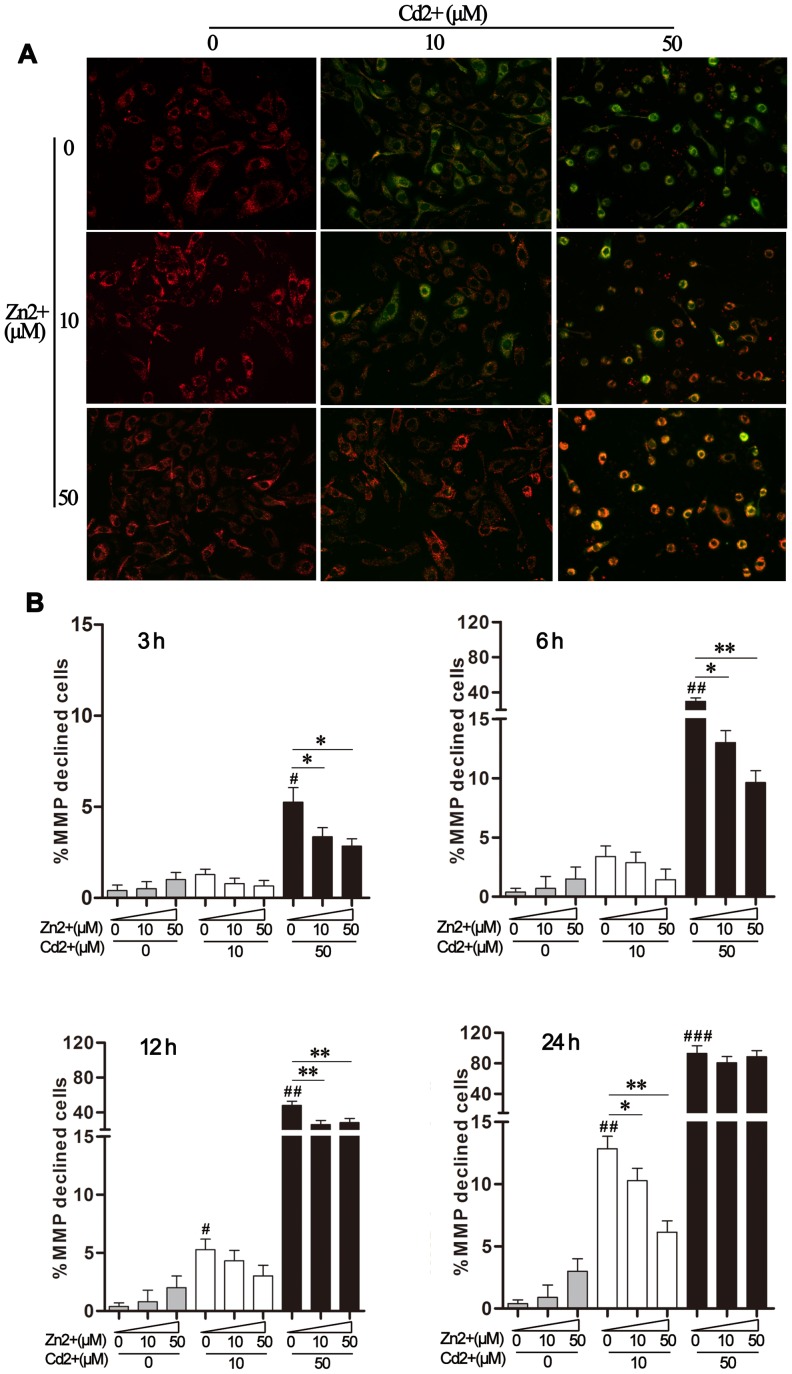
Effect of Zn2+ on Cd2+-triggered mitochondrial depolarization.(A) MDBK cells were treated with Cd2+ alone (0, 10, 50 μM), or in combination with Zn2+ (0, 10, 50 μM), for 6 h. Mitochondrial membrane polarization (MMP) was determined by staining with JC-1 probe and imaging using a fluorescence microscope at ×200 magnification. (B) MDBK cells were treated as described above for the indicated time periods. The percentage of green fluorescent cells (indicating reduced MMP) was quantified by flow cytometry. Values shown are the mean ± SD (n = 4). #P<0.05, ##P<0.01, and ###P<0.001 compared to the medium-treated control group; *P<0.05 and **P<0.01 compared to the cells exposed to Cd2+ alone (10 or 50 μM).